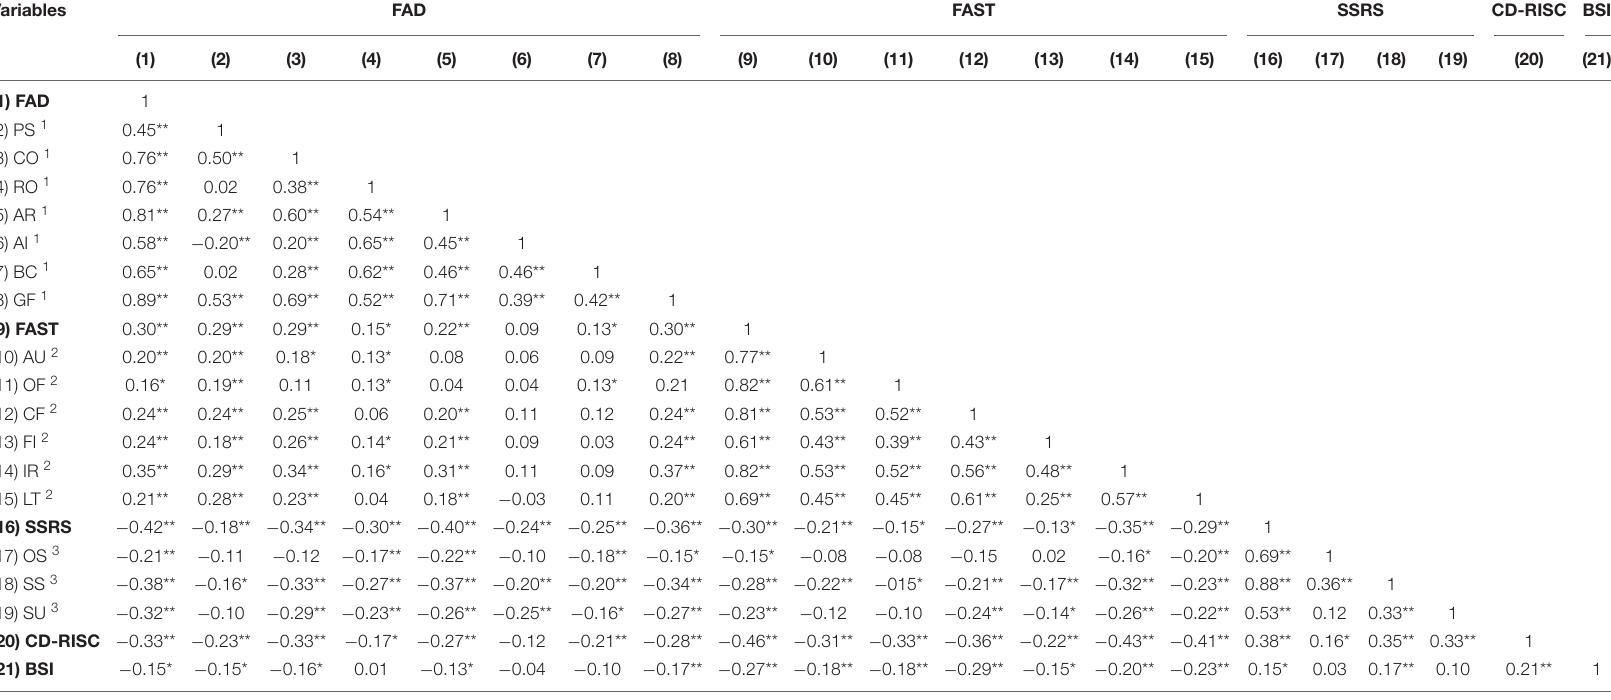
TABLE 3 | The partial correlations # among family functioning, psychosocial functioning, social support, resilience and suicidal ideation in patients with bipolar disorder.